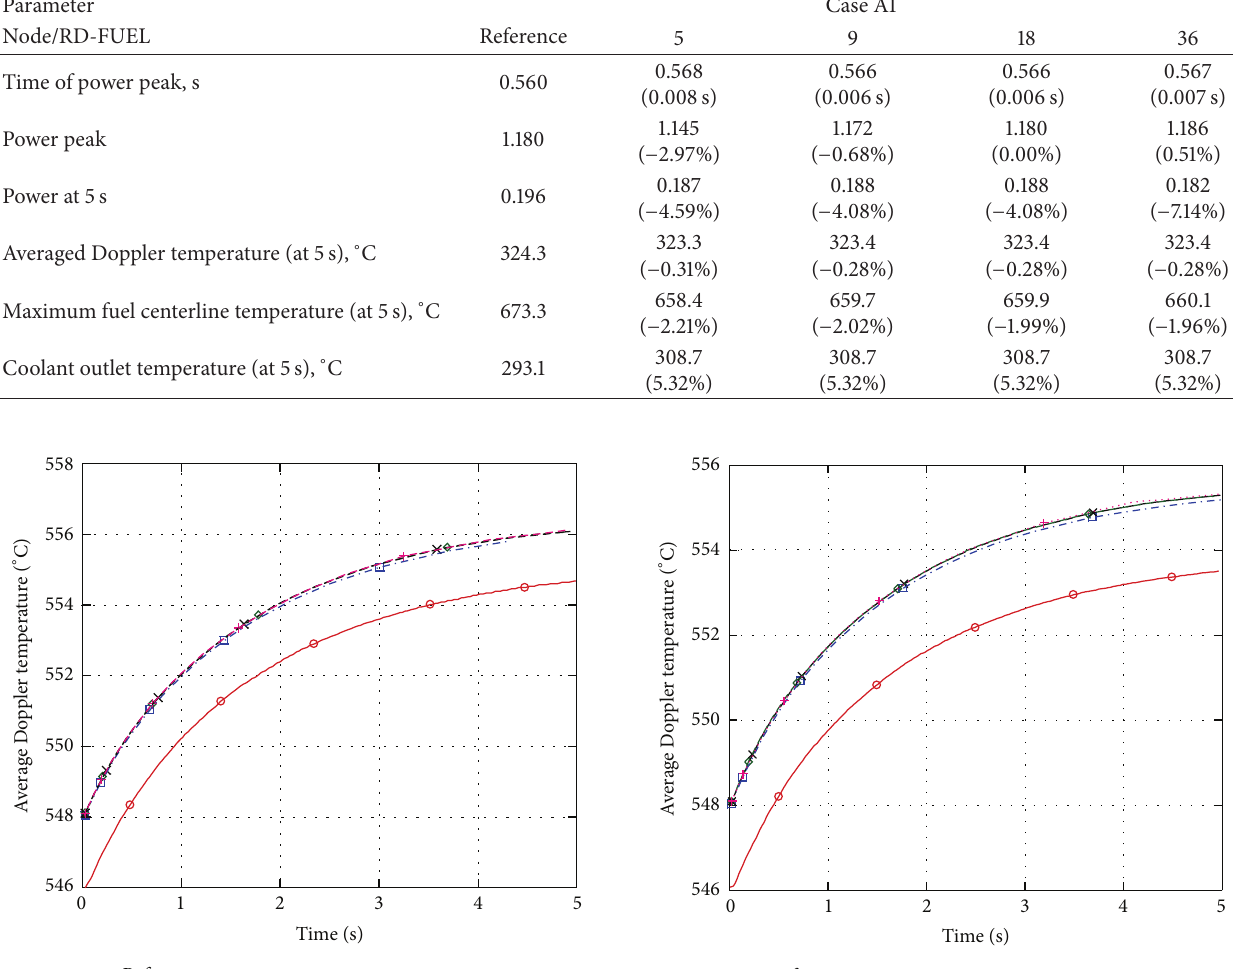
Table 10: Sensitivity analysis results in the number of nodes for the fuel pellet heat conduction for case A1.